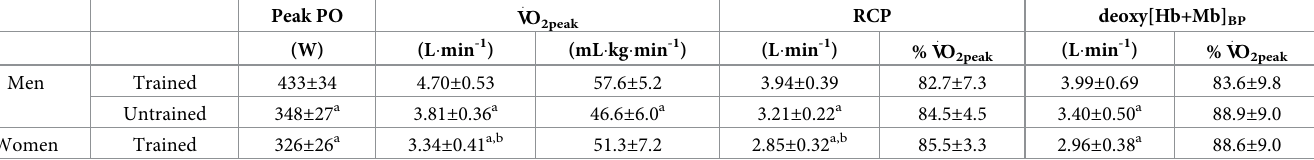
Table 1. Ramp incremental test results including peak power output (Peak PO), peak rate of oxygen uptake ( V : O 2peak ), respiratory compensation point (RCP), and the deoxygenated [hemoglobin + break point] (deoxy[Hb+Mb] BP